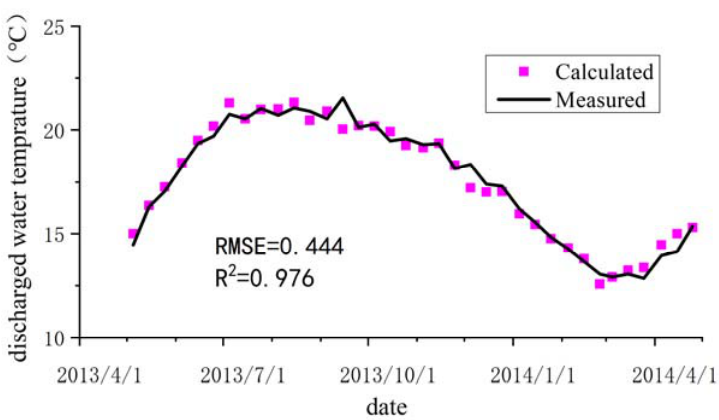
Figure 8. Comparison of the calculated and measured values of discharged water temperature.